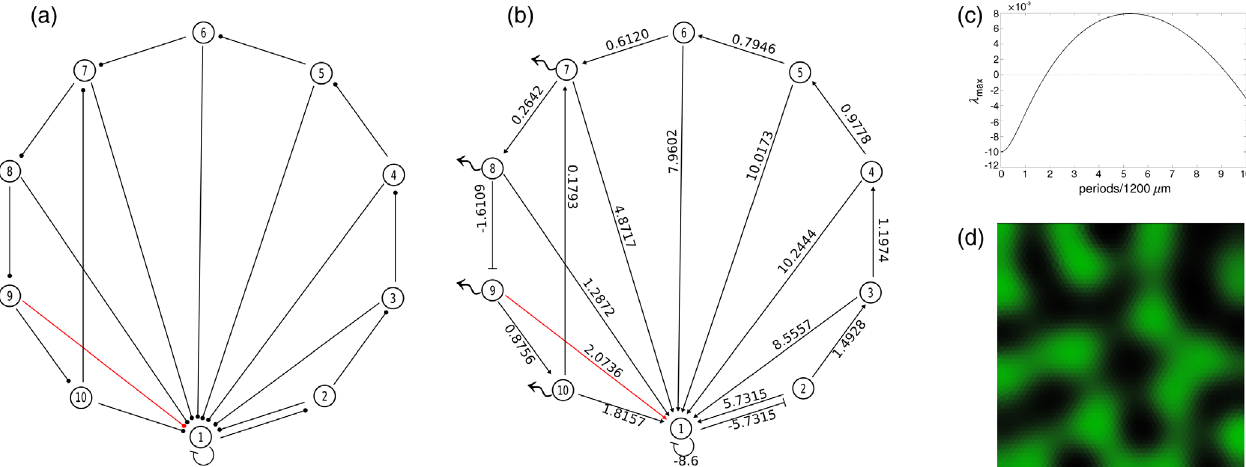
FIG. 10. (a) A ten-node Turing topology. The last edge of the destabilizing cycle is highlighted in red. (b) Distribution of edge signs that make a ten-node Turing network based on the topology in (a). Parameter values are found with a search method tailored for very large systems. (c) Dispersion relationship and (d) numerical simulation of the stationary pattern generated with the parameter values shown in